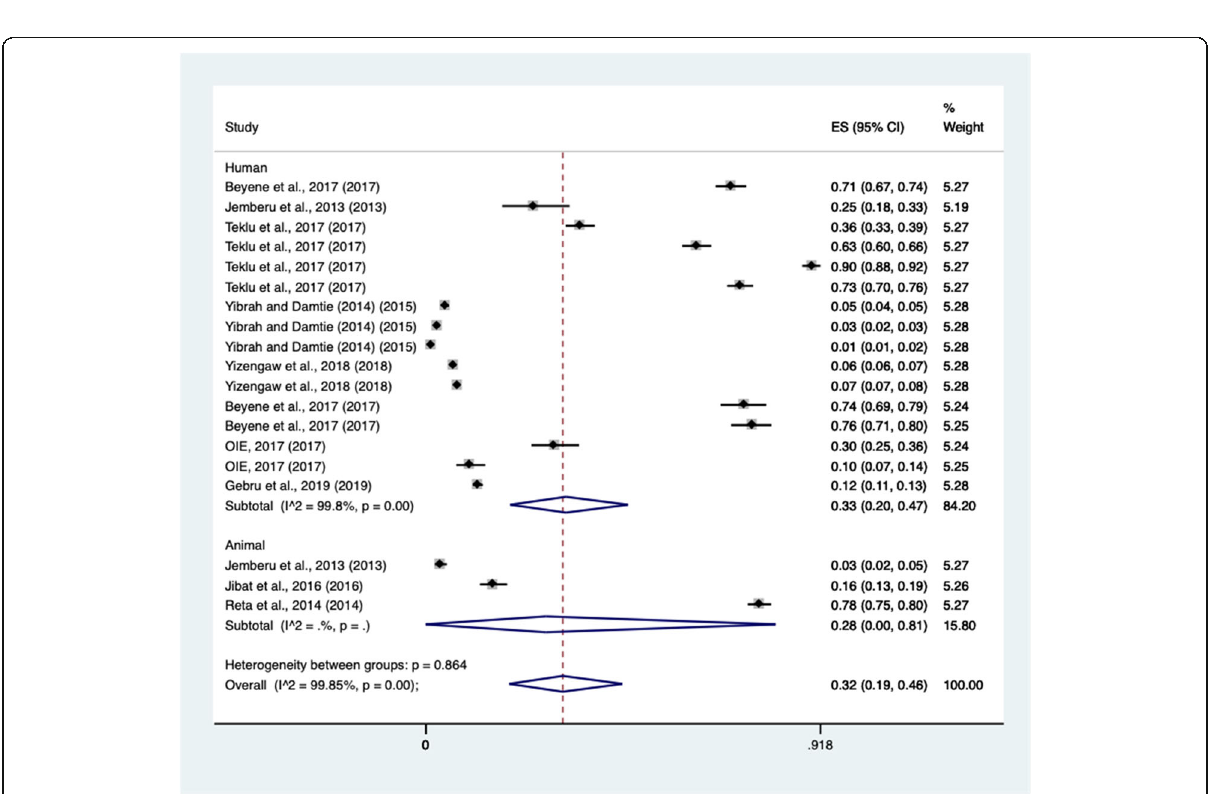
Fig. 3 Subgroup meta-analysis by host species